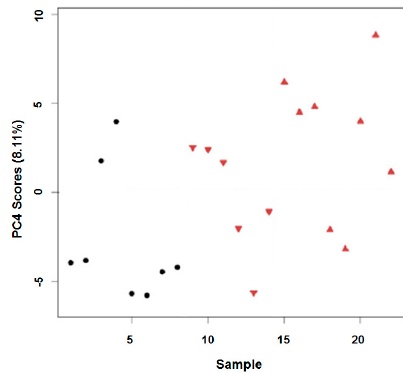
Figure 5. Scores plot showing sample vs. principal component 4 (PC4) for in vivo D. magna exposures to CuSO 4 . Control samples (1–8) are denoted by black circles ( ), CuSO 4 exposed samples (8–21) are denoted by red triangles (2 µg/L , 20 µg/L ).